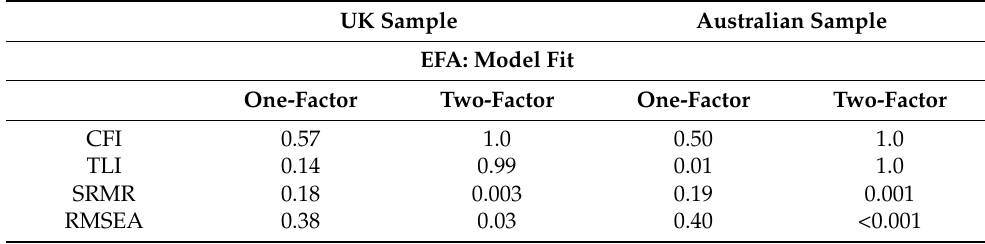
Table 2. Model fit for the initial EFA performed on the selected BeSD items.